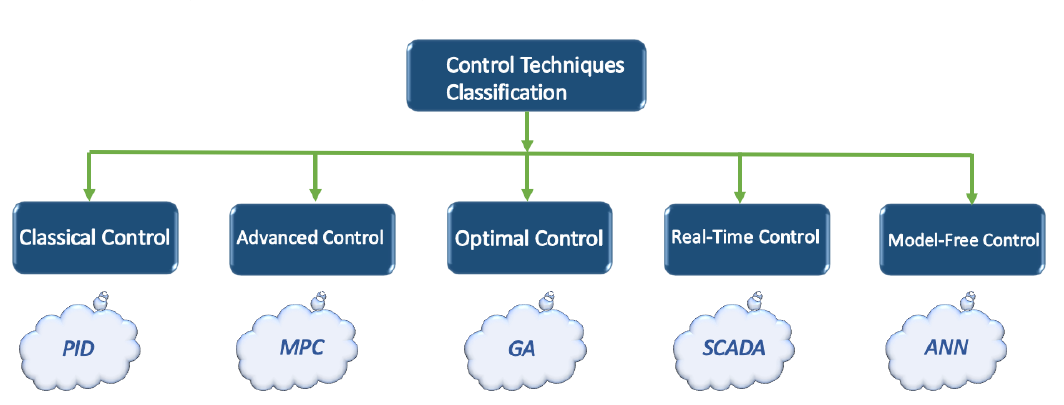
Figure 2. Classification of control